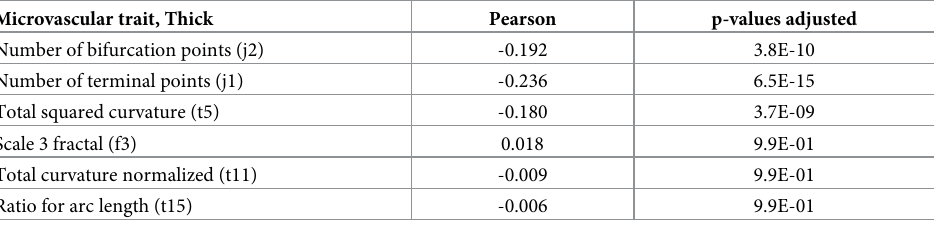
Table 3. Correlation with age for AREDS microvascular traits.